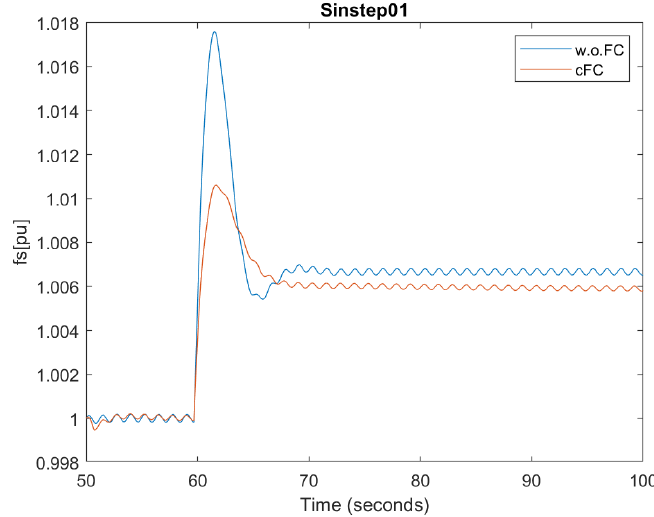
Figure 16. Simulation 5 frequency trend.